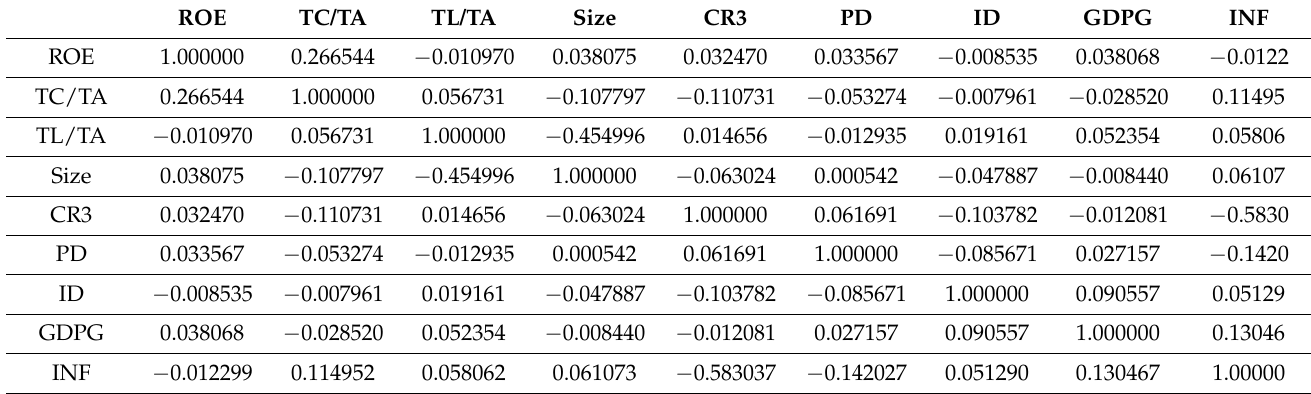
Table A2. Correlation matrix for the ROE model.